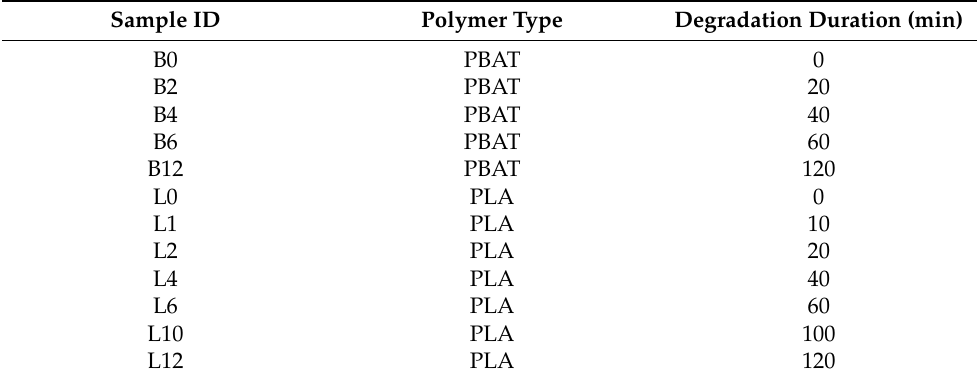
Table 1. Sample ID of (hydrolyzed) PBAT and (methanolyzed)